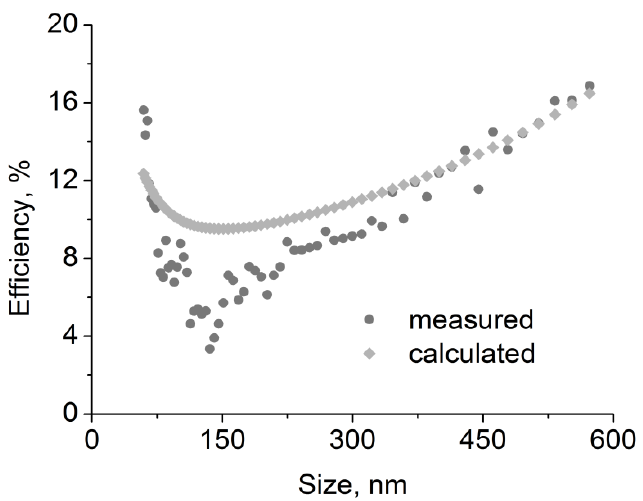
Figure 8. Measured and calculated fractional efficiencies for oil aerosol for 2F6 filter.